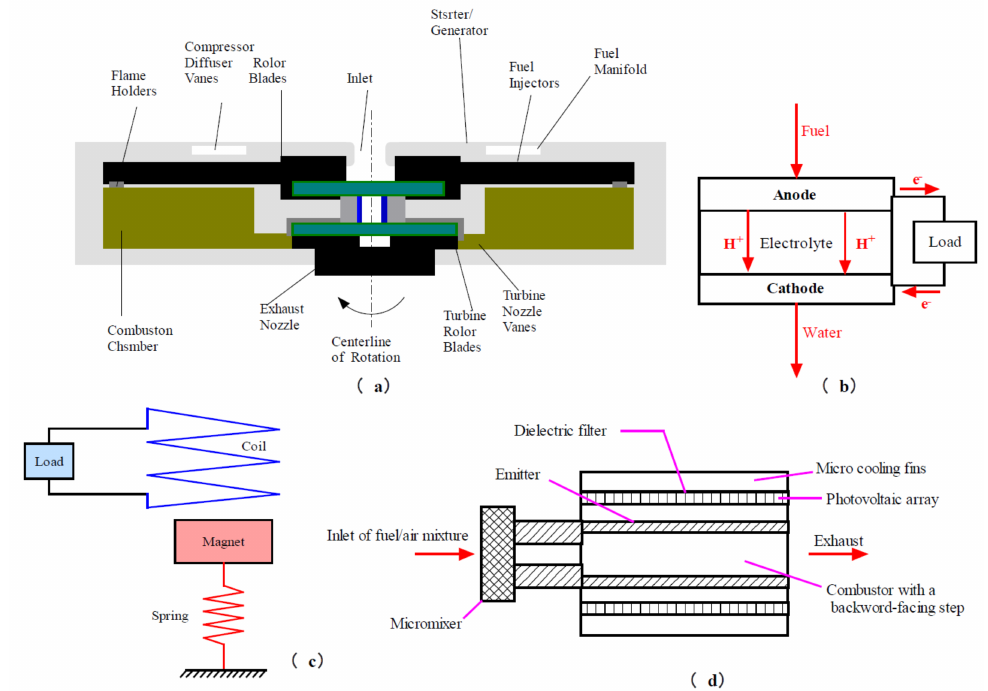
Figure 2. The micropower generation devices, ( a ) Baseline engine, ( b ) Micro-rotary engine, ( c ) Electromagnetic system schematic, ( d )